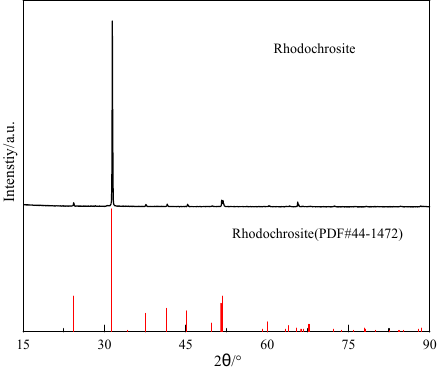
Figure 1. XRD pattern of the rhodochrosite and corresponding PDF standard card.